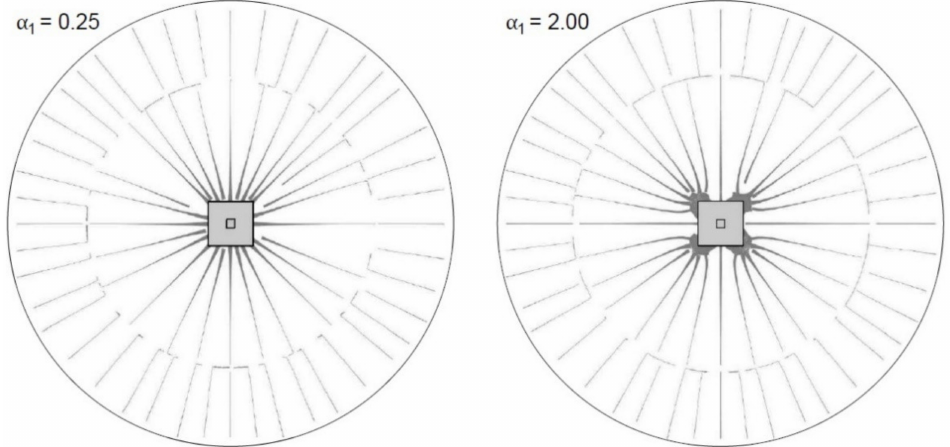
Figure 5. Examples of shear force flow maps obtained from the